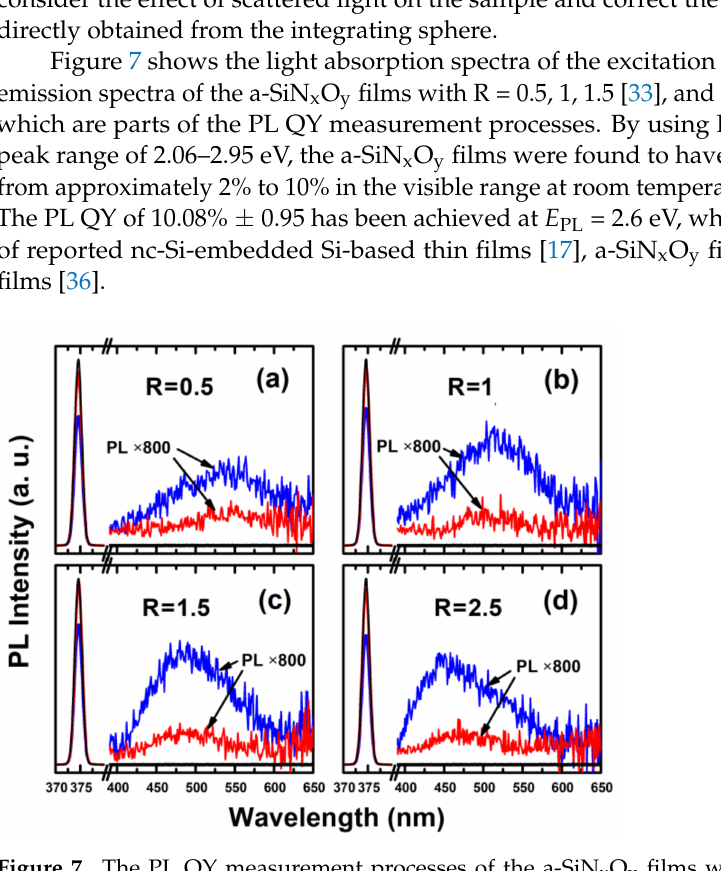
Figure 7. The PL QY measurement processes of the a-SiN x O y films with ( a ) R = 0.5; ( b ) R = 1; ( c ) R = 1.5 (Reprinted from ref. [33]); ( d ) R = 2.5. Black line: the total incident excitation photons ( left ). Red line: the unabsorbed excitation photons ( left ) and corresponding emitted photons ( right ) when the excitation source is directly shone onto samples. Blue line: the unabsorbed excitation photons ( left ) and corresponding emitted photons ( right ) when the excitation source is indirectly shone onto